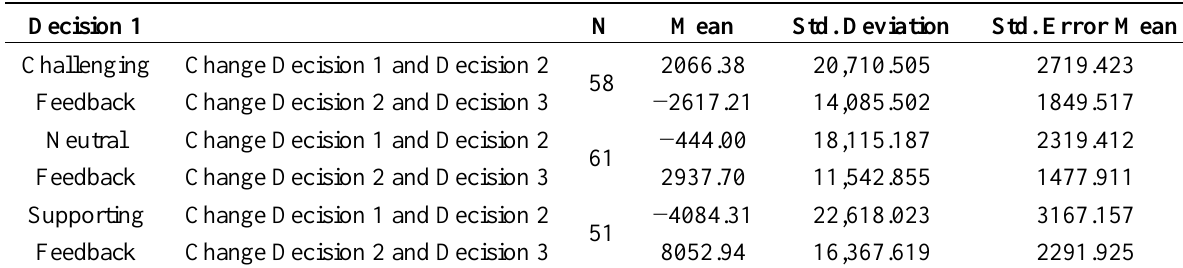
Table 3. Summary Statistics.